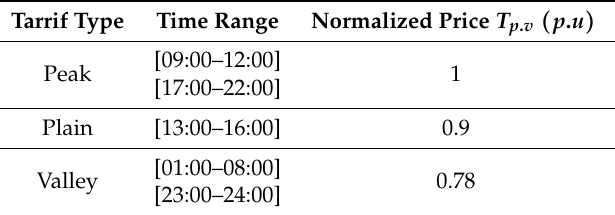
Table 1. Peak-Valley Electricity